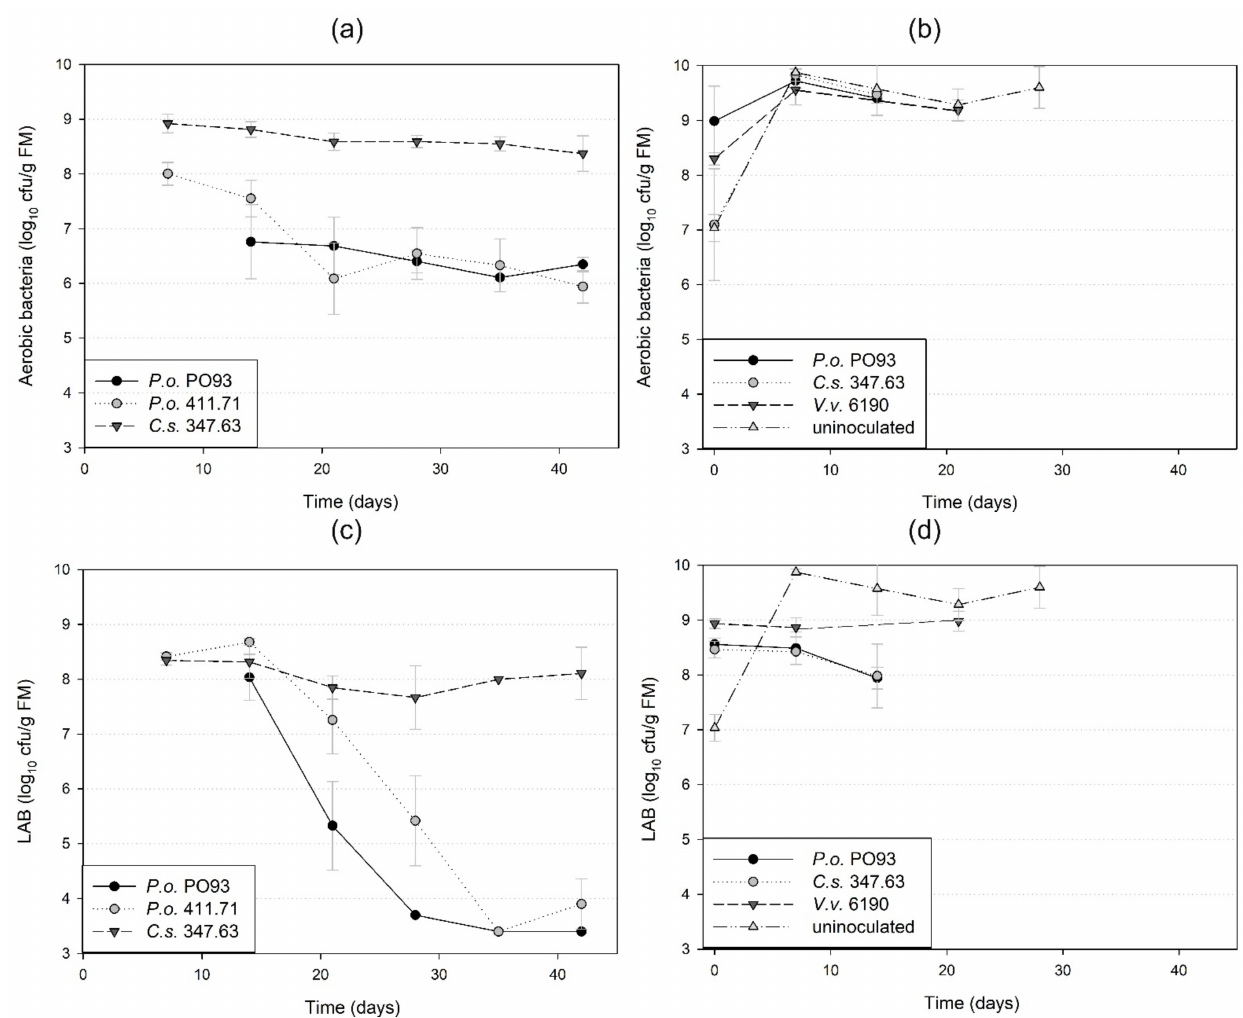
Figure 4. Numbers of aerobic mesophilic bacteria and lactic acid bacteria (LAB) found on straw treatments. Aerobic mesophilic bacteria on ( a ) drained, ( b ) remoistened straw. LAB on ( c ) drained, ( d ) remoistened straw. P.o. — Pleurotus ostreatus ; C.s. — Ceriporiopsis subvermispora ; V.v. — Volvariella volvacea . Error bars indicate the standard deviation